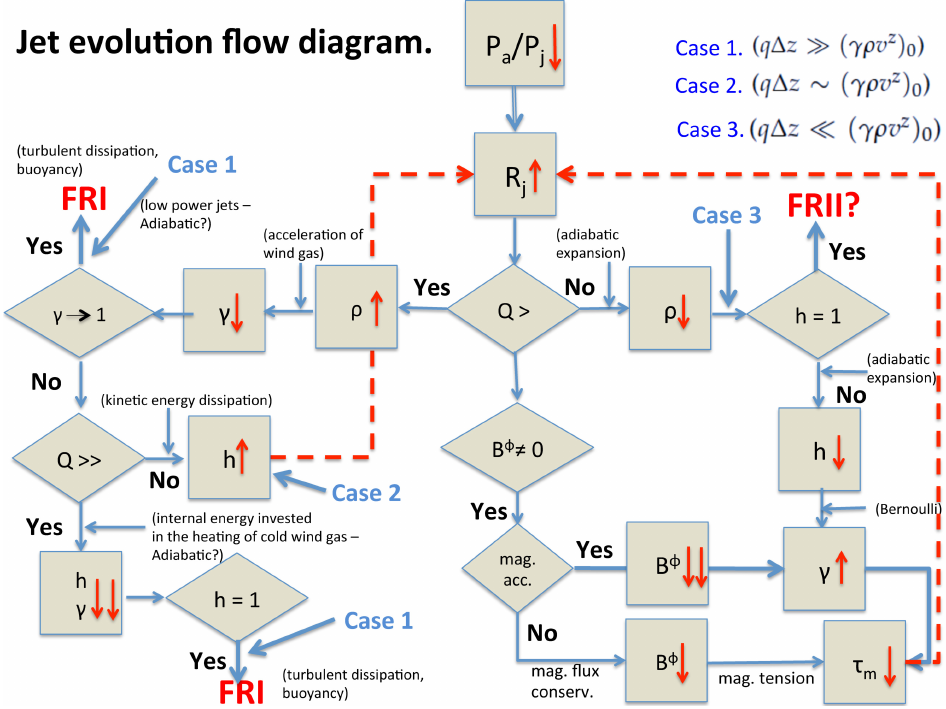
Figure 12. Flow diagram of jet evolution as it propagates through a galactic atmosphere. The rhombi indicate the bifurcations in the flow diagram depending on which processes dominate the dynamics, and the squares indicate the result of those processes. I have indicated the possible evolutionary options related to mass load in blue. Adapted from Perucho et al., in preparation (see also [164]). Please note that where case 1 is indicated, the jet evolution can be non-adiabatic [27]. Case 2 may imply